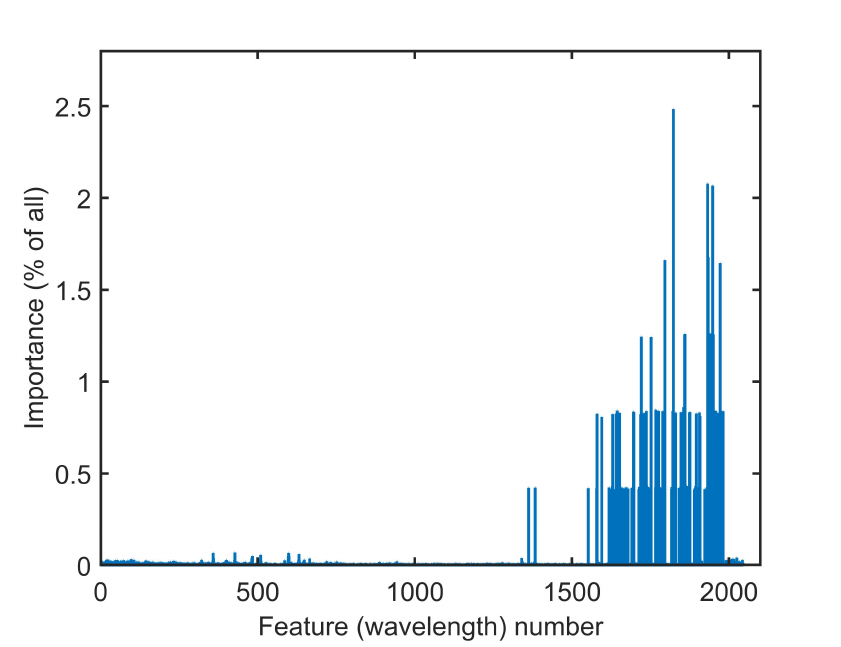
Figure 7. Spectrometer feature (wavelength) importances obtained by RF.